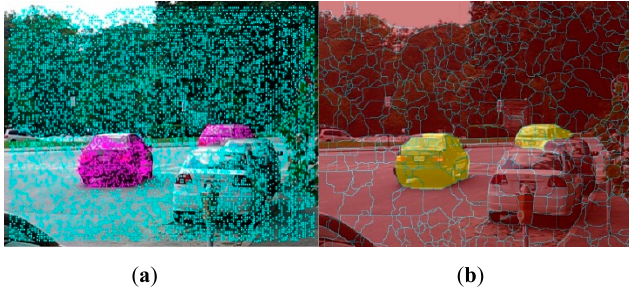
Figure 3. Example of initial trajectory classification and final pixel labeling. The selected image is from cars 2 video sequence of Hopkins 155 [40] dataset. ( a ) Example of initial trajectory classification. ( b ) Example of final pixel level labeling.